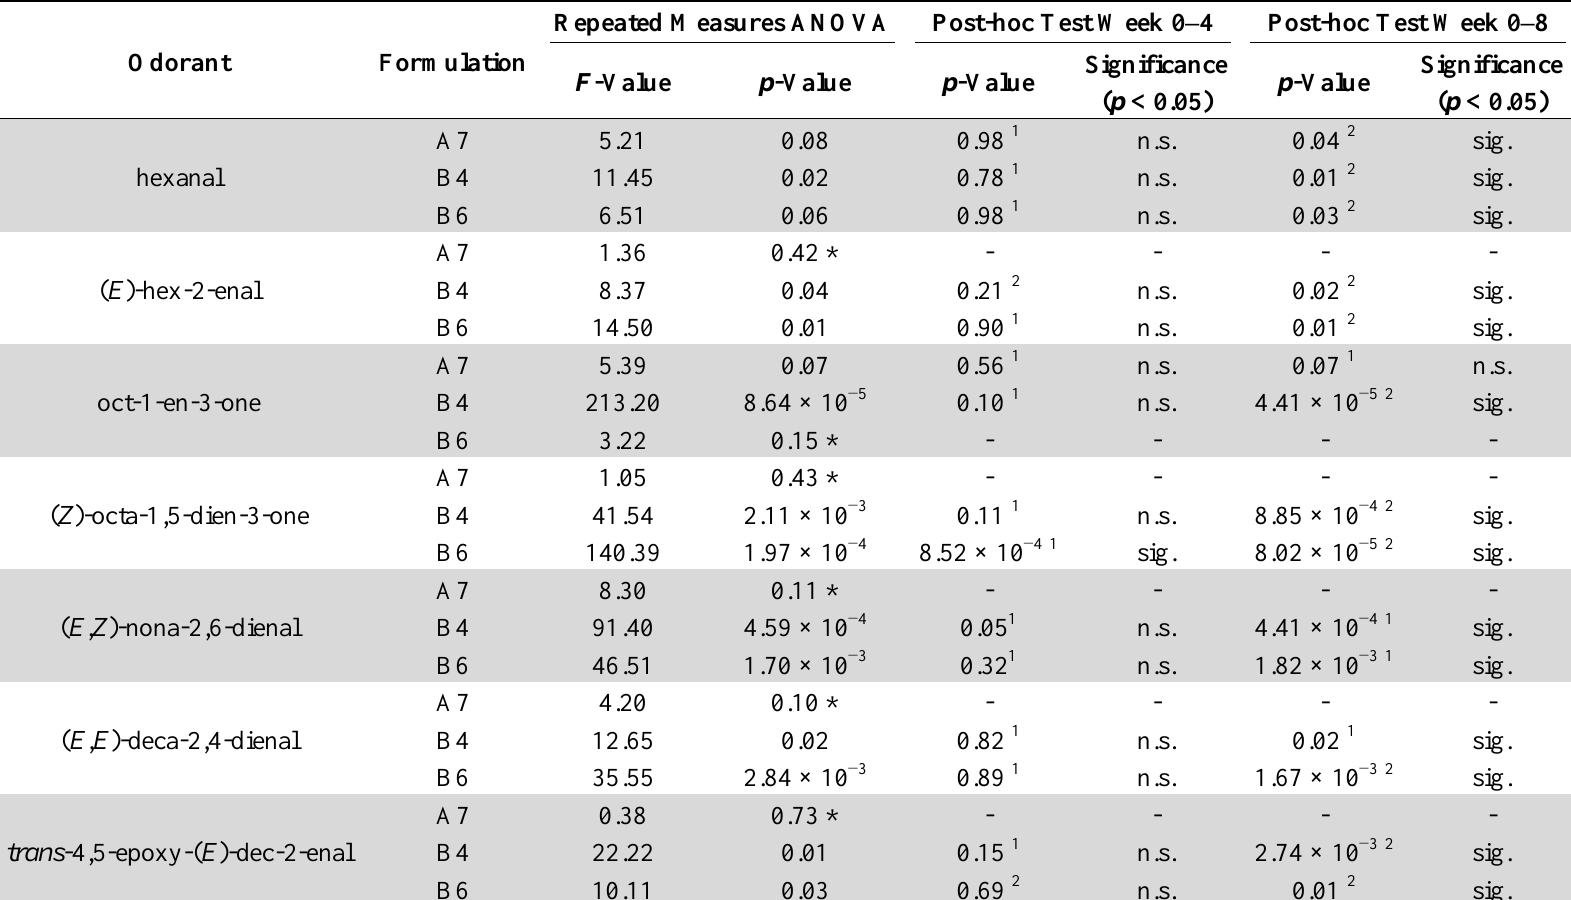
Table 8. Statistical data on one-way repeated ANOVA combined with posthoc-test 1,2 for pairwise comparison of the means: analysis of lipid oxidation via secondary lipid oxidation products over storage